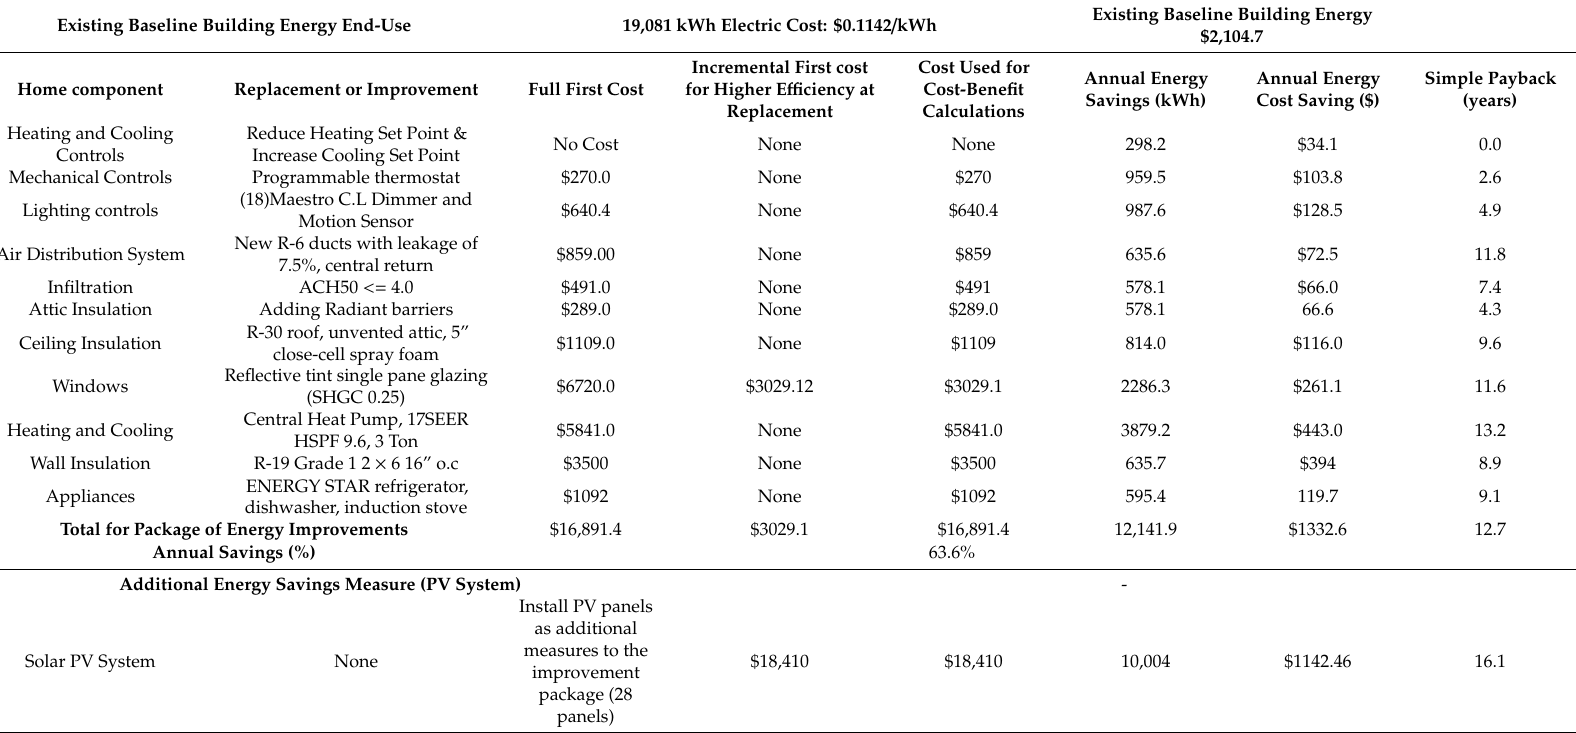
Table 9. Proposed Retrofit Improvement